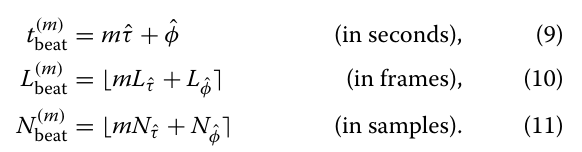
The estimated position of the m ’th beat is (with (cid:3)·(cid:4) rounding to the nearest integer):